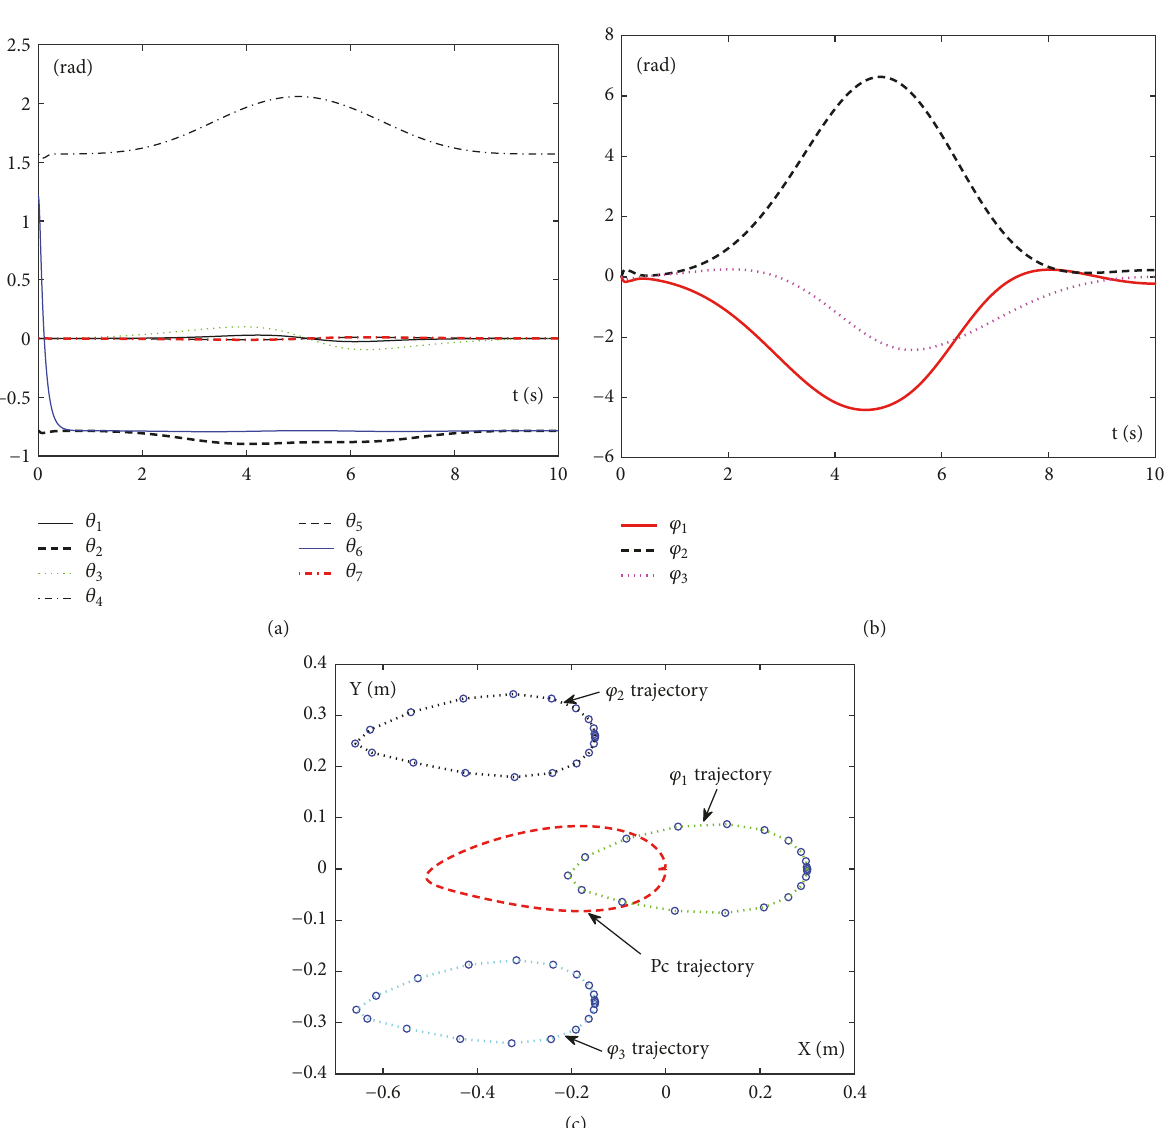
Figure 7: Profiles about the free joint angles of the mobile manipulator. (a) Motion trajectories of each joint angle of redundant manipulator PA10. (b) Rotating profiles for three wheels. (c) Motion trajectories with the mobile